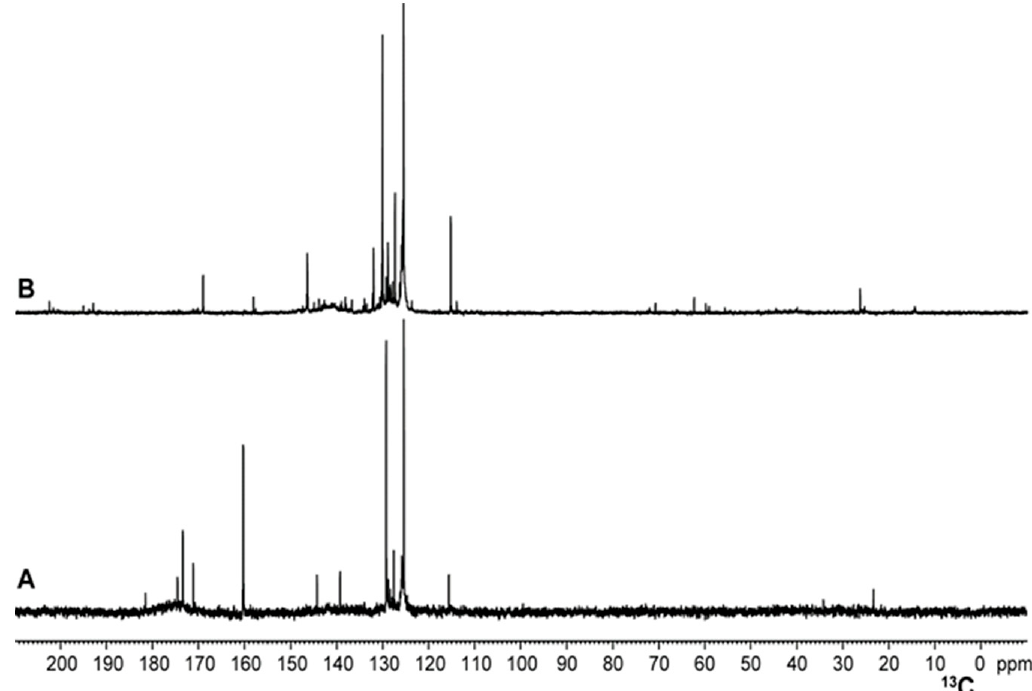
Figure 5. 13 C NMR spectra of FA samples extracted from soil ( A ) and water ( B ).